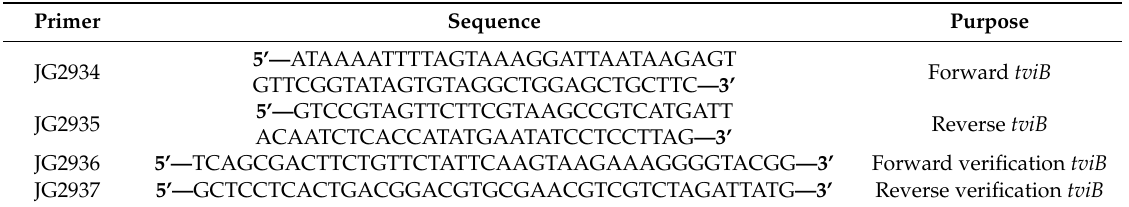
Table 3. Oligonucleotide primers used in this